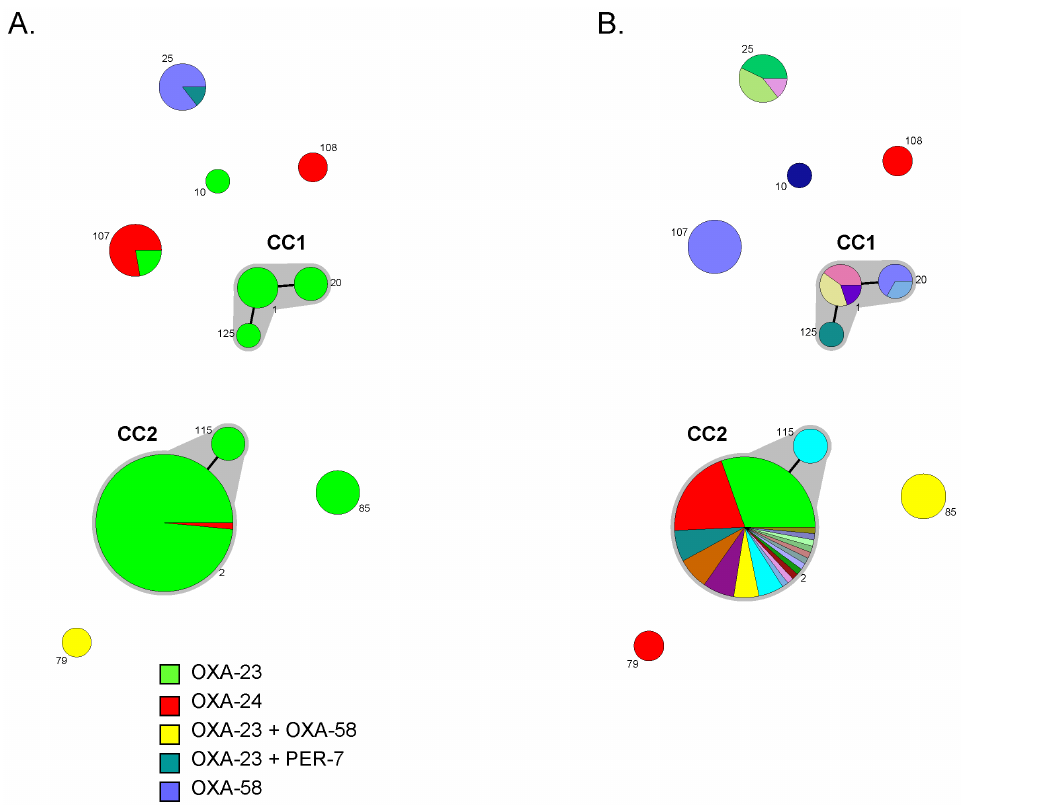
Fig. 2. Genetic diversity of carbapenem-non susceptible A. baumannii from France. Each circle represents a sequence type (ST), which number is given besides the circle. The size of circles is related to the number of isolates. Grey zones between circles represent clonal complexes. The relative positioning of clonal complexes and singletons STs is not necessarily related to their genetic proximity. A: Coloured sectors inside circles denote the proportion of isolates with each enzyme or combination thereof, as indicated in the key. B: Coloured sectors inside circles denote the proportion of isolates from each healthcare centre (arbitrary colours, with no correspondence with those in Fig.